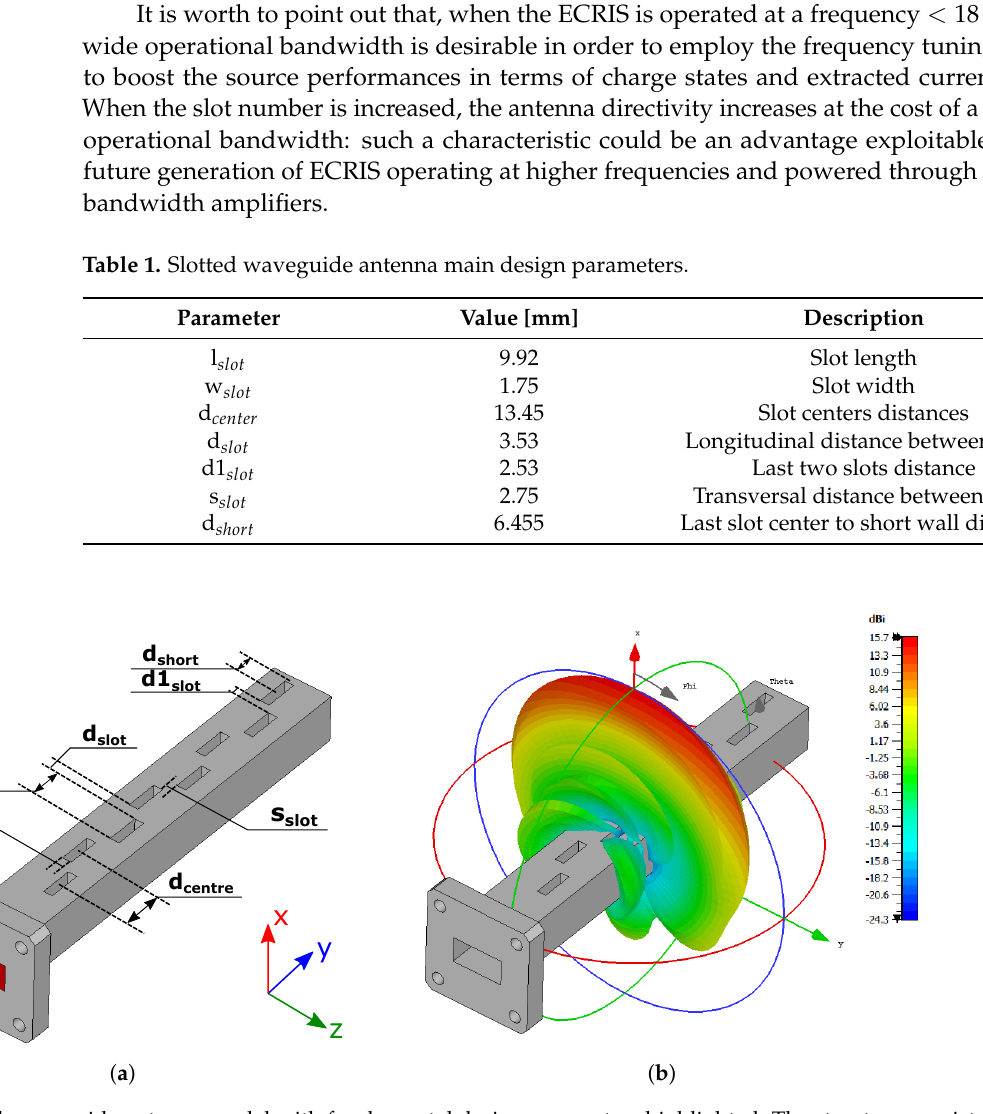
Figure 5. ( a ) Slotted waveguide antenna model with fundamental design parameters highlighted. The structure consists of a steel block (grey object) fed through a waveguide port, highlighted in red. ( b ) Farfield pattern of the presented slotted waveguide